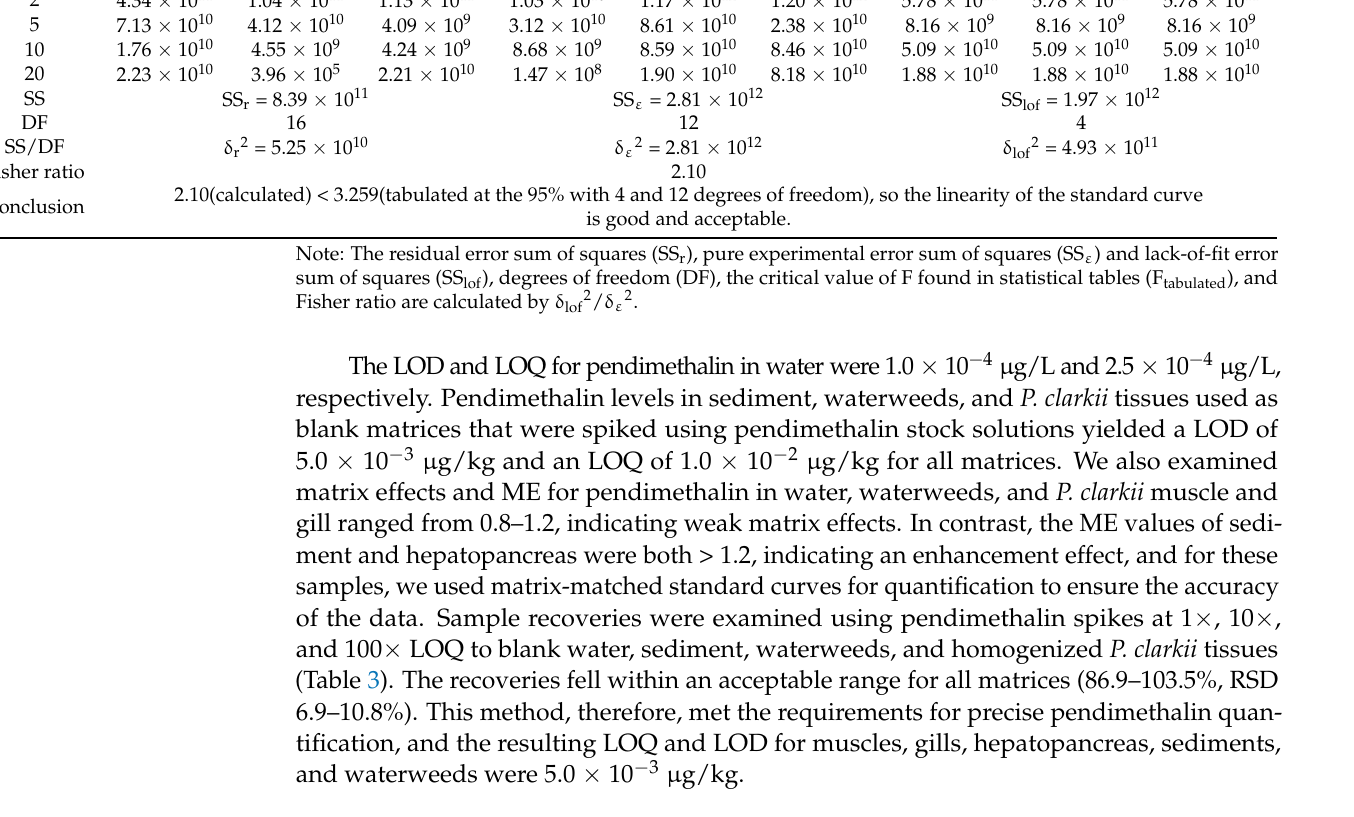
Table 3. Recoveries in different matrices with pendimethalin spikes at 1 × , 10 × , and 100 ×